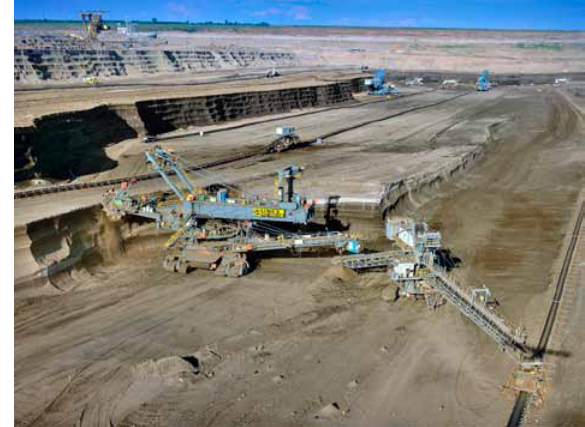
Fig. 1. Surface mining – Libouš mine